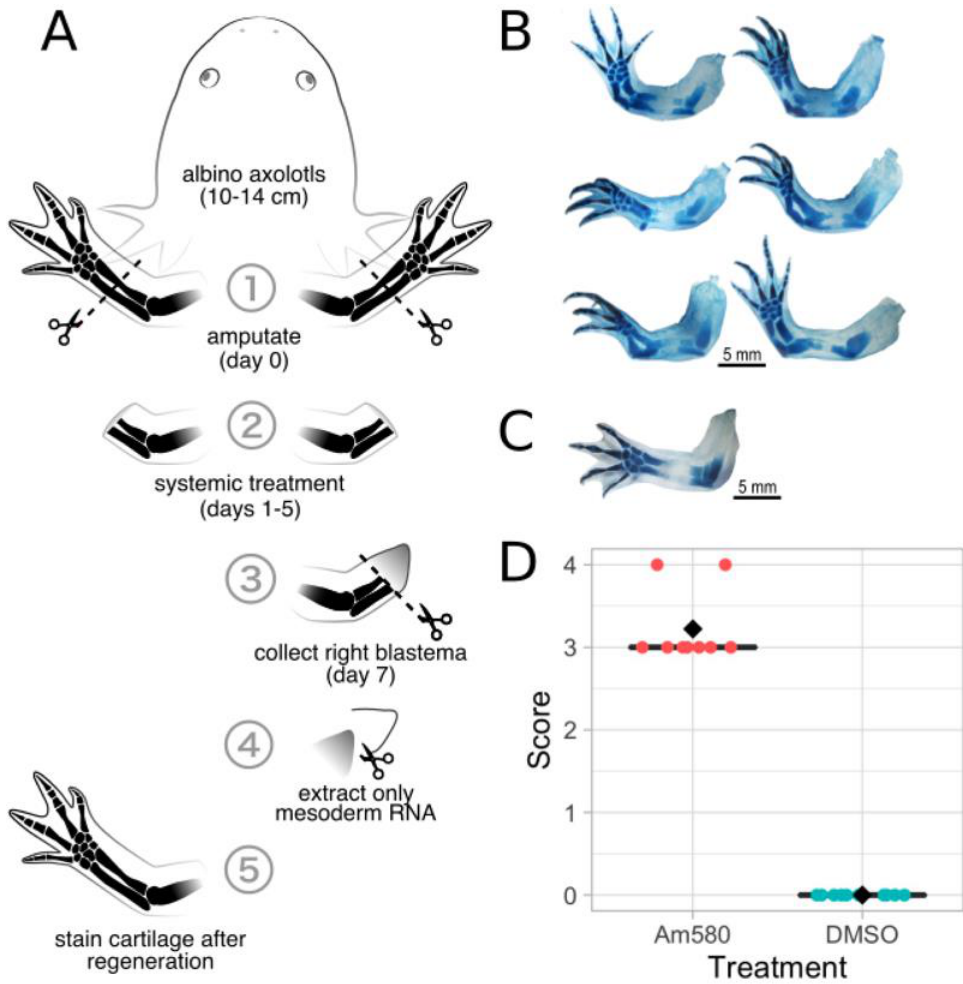
Figure 5. ( A ) Experimental design for both DMSO control ( n = 10) and 25 nM RAR α ( n = 10) treatments. Both forelimbs are amputated mid-zeugopod at day 0 and treated systemically with either DMSO or Am580 on days 1–5. The right blastema is collected on day 7, the epidermis removed, and RNA extracted from the mesoderm. The left blastema serves as an observational control. ( B ) Left forelimb regenerates collected from the six axolotls that were selected for RNA-sequencing; ( C ) A representative left forelimb regenerate collected from a DMSO-treated axolotl. ( D ) Limb duplication scores for all left limbs in the Am580-treatment and DMSO-control groups. The Am580-treated limbs scored 3.2, an increase in PD duplication compared to DMSO controls (mean score of 0).